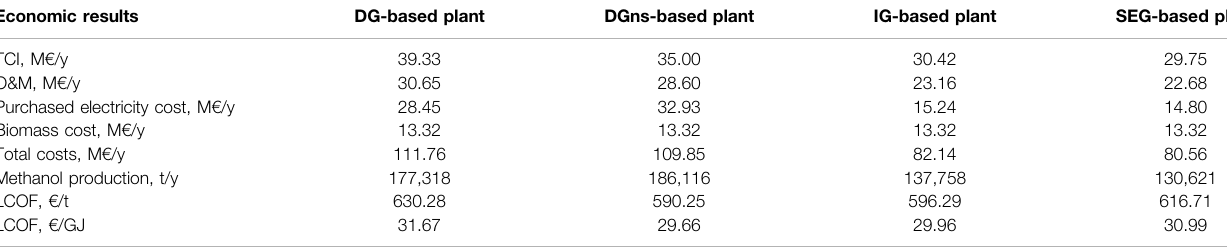
TABLE 10 | Main result of the economic analysis and levelized cost of fuel for an electrolyzer investment cost of 700 €